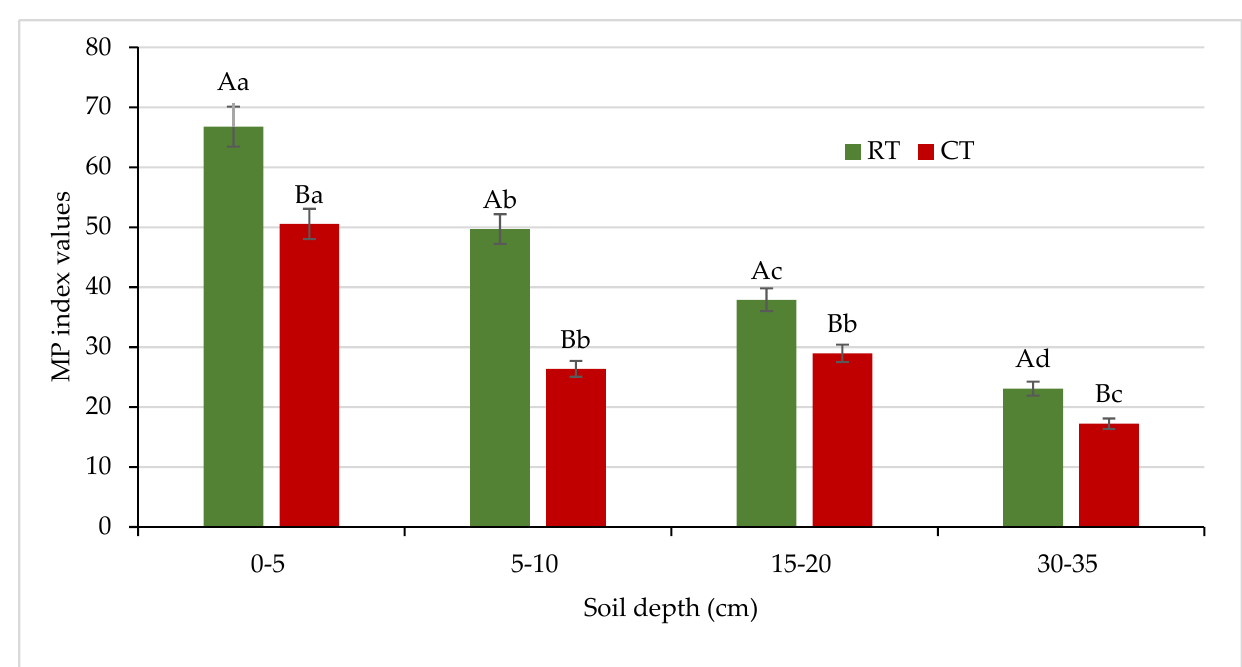
Figure 14. Values of metabolic potential index in soil under different tillage systems in 2018–2020 (means for the 3 years are presented in each column, n = 12). Different letters represent significant differences ( p ≤ 0.05) across treatments according to Tukey’s HSD test; lowercase letters within the same tillage system indicate significant differences between soil depths; uppercase letters indicate differences between tillage systems. MP—metabolic potential index; DEH—dehydrogenase activity; WEC—water-extractable carbon; RT—reduced tillage system; CT—conventional tillage system; n— number of samples. Vertical bars represent standard errors.